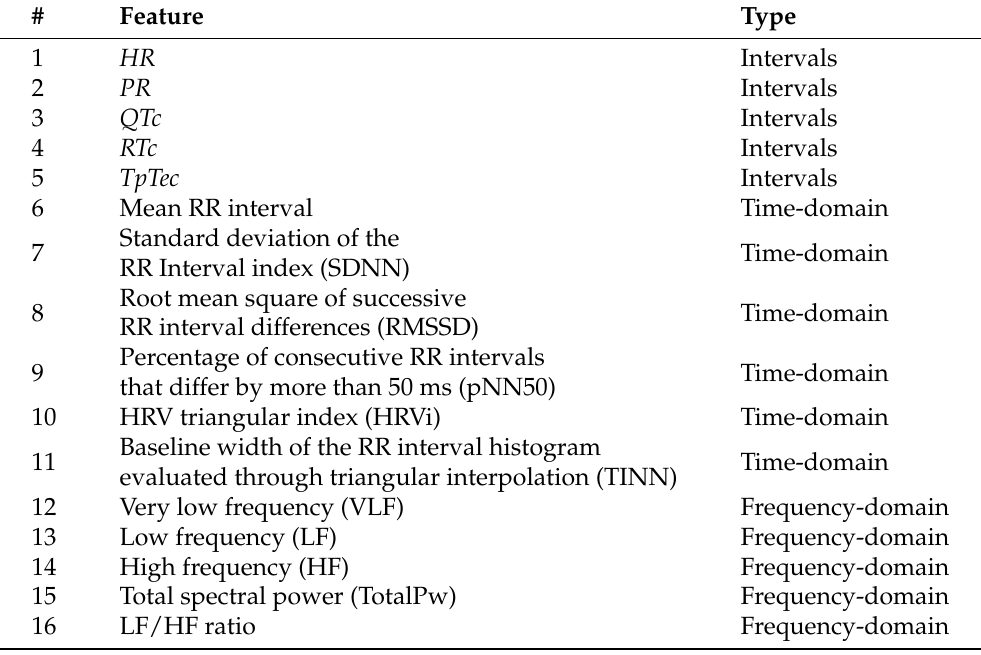
Table 1. Features list used by Nguyen et al. [6] to calculate hyperglycemia.